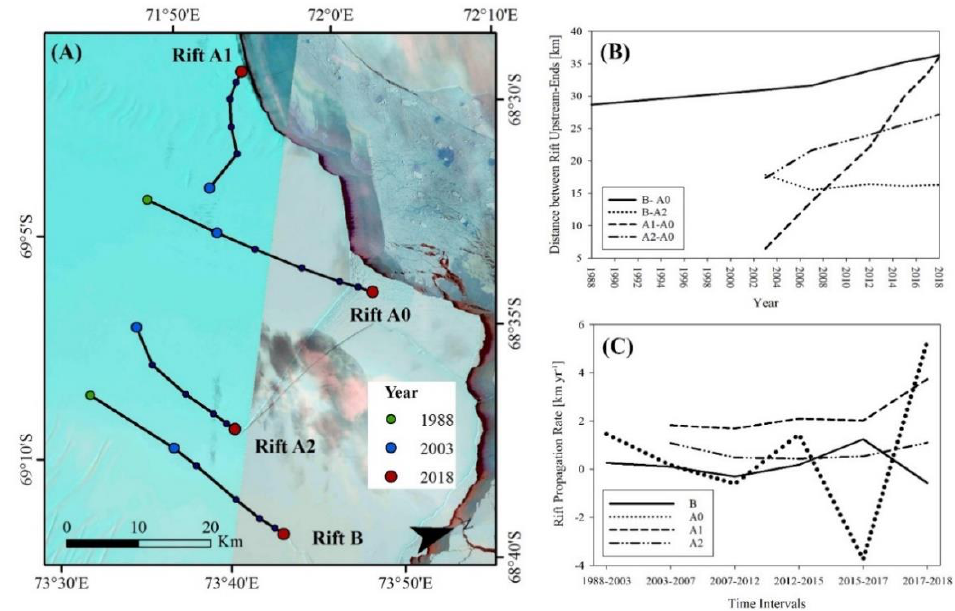
Figure 3. ( A ) The locations of the upstream ends of rifts A0, A1, A2, and B, ( B ) the distance sepa- rating the upstream ends of the studied rifts, and ( C ) the propagation rate of rifts A0, A1, A2, and B during 1988 – 2018. The upstream end of each studied rift is marked as a solid dot shown in Figure 3A. It is worth noting that rift A1 propagated approximately 108 km westward away from its location in 2003.